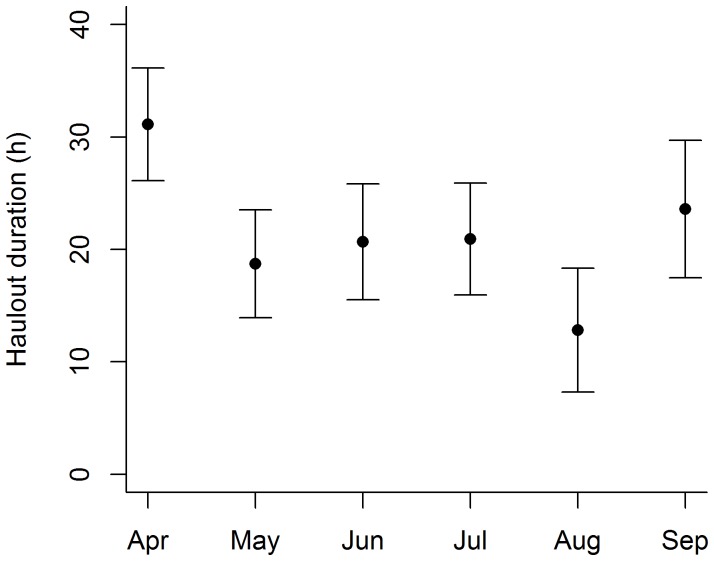
Seasonal effects on haul-out durations.Differences in the duration of haul-out periods throughout the second half of the lactation period for female Australian fur seals provisioning young at Kanowna Island, Bass Strait, Australia. (values taken from the coefficient estimates and corresponding standard errors of the LME model. see Table 3 for statistical results).